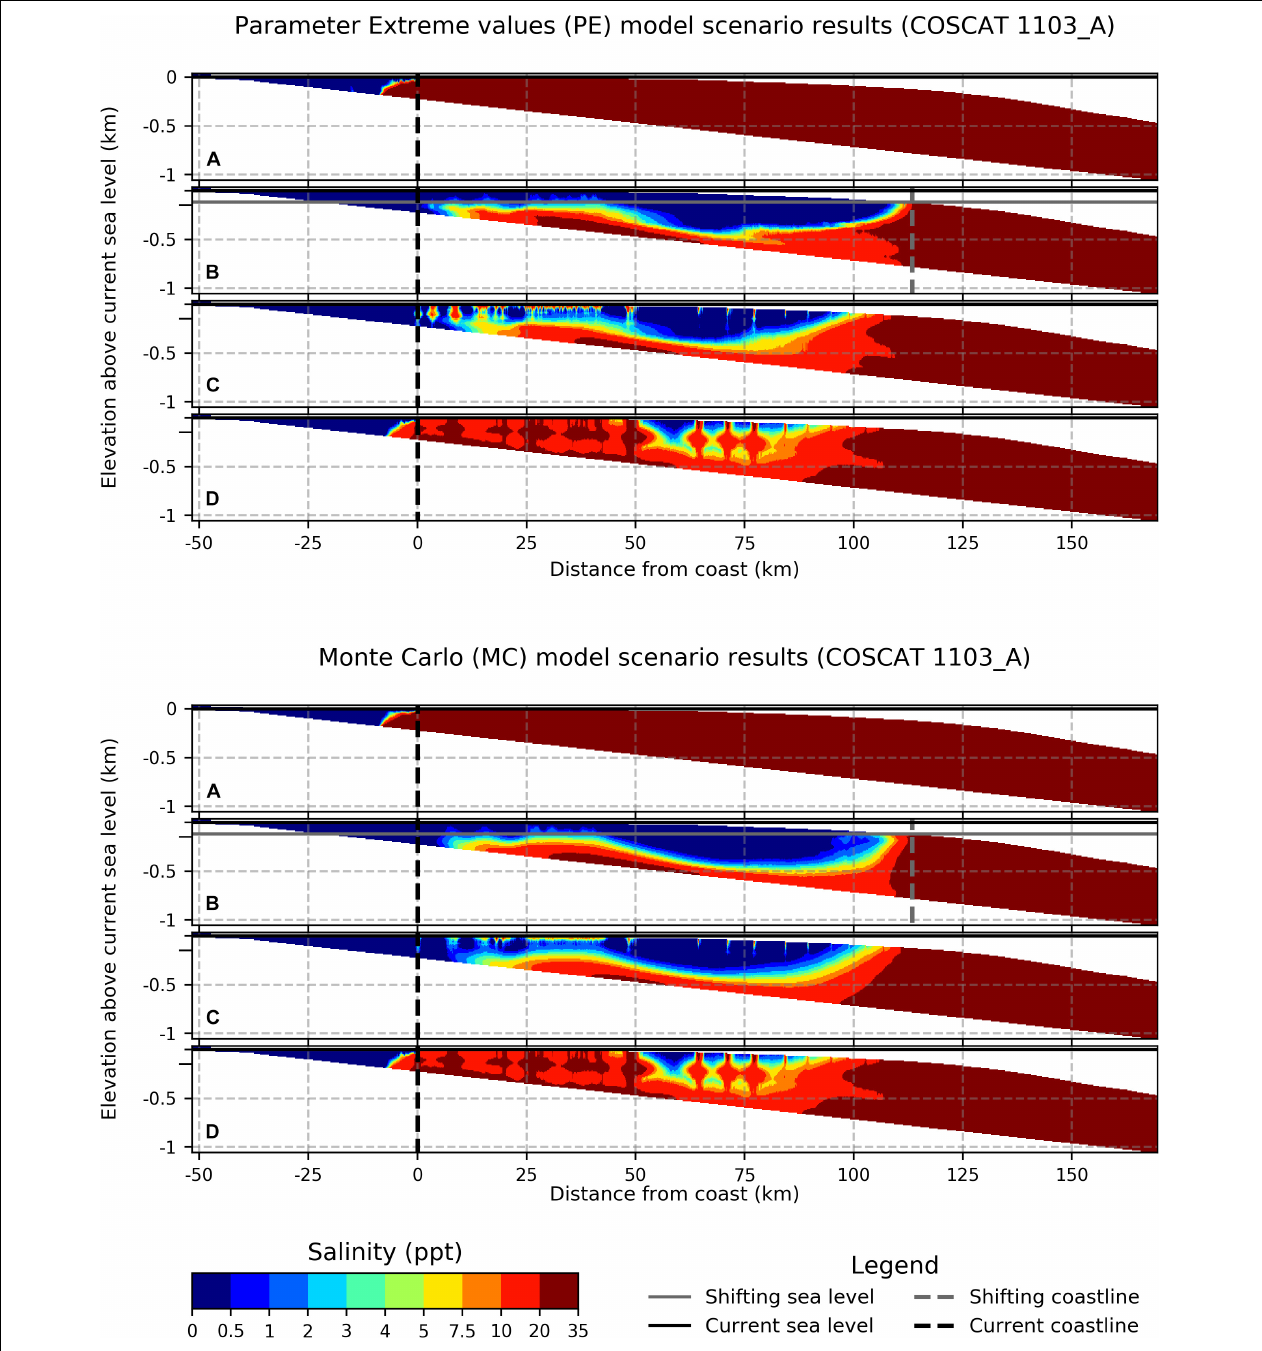
FIGURE 10 | Averaged groundwater salinity profiles for both modeling concepts at four timeframes for COSCAT 1103_A region (Suriname). The estimated groundwater salinity in the 2D profiles is represented: (A) at the end of SP 0, groundwater salinity before fluctuating sea-level SPs; (B) at the lowest sea level occurring at the end of the sea-level drop represented by SP 21; (C) after the relatively fast sea-level rise back to the current sea level at the end of SP 31; and finally (D) estimation of future conditions in 20 ka from present at the end of SP 31_DSP. The results of the other eight SEAWAT models are provided in the Supplementary Material